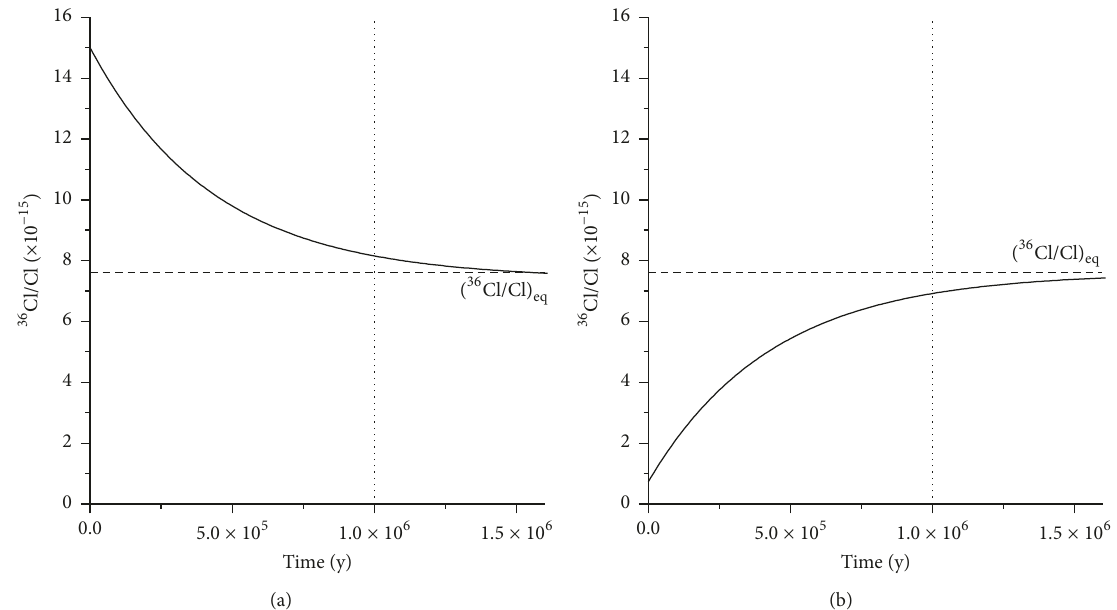
Figure 9: The example relationships between time and 36 Cl/Cl; (a) was calculated with initial values of 36 Cl/Cl = 15 × 10 −15 and ( 36 Cl/Cl) se = 7.6 × 10 −15 , and (b) was calculated with initial values of 36 Cl/Cl = 0.76 × 10 −15 and ( 36 Cl/Cl) over 1 million years. 15×10 −15 was chosen because it was a calculated ( 36 Cl/Cl) to ( 36 Cl/Cl) se to the Wakkanai formation. 0.76 × 10 −15 was chosen because it is a 36 Cl/Cl value for sea water [42] and ( 36 Cl/Cl) because it was calculated value for the Wakkanai formation.